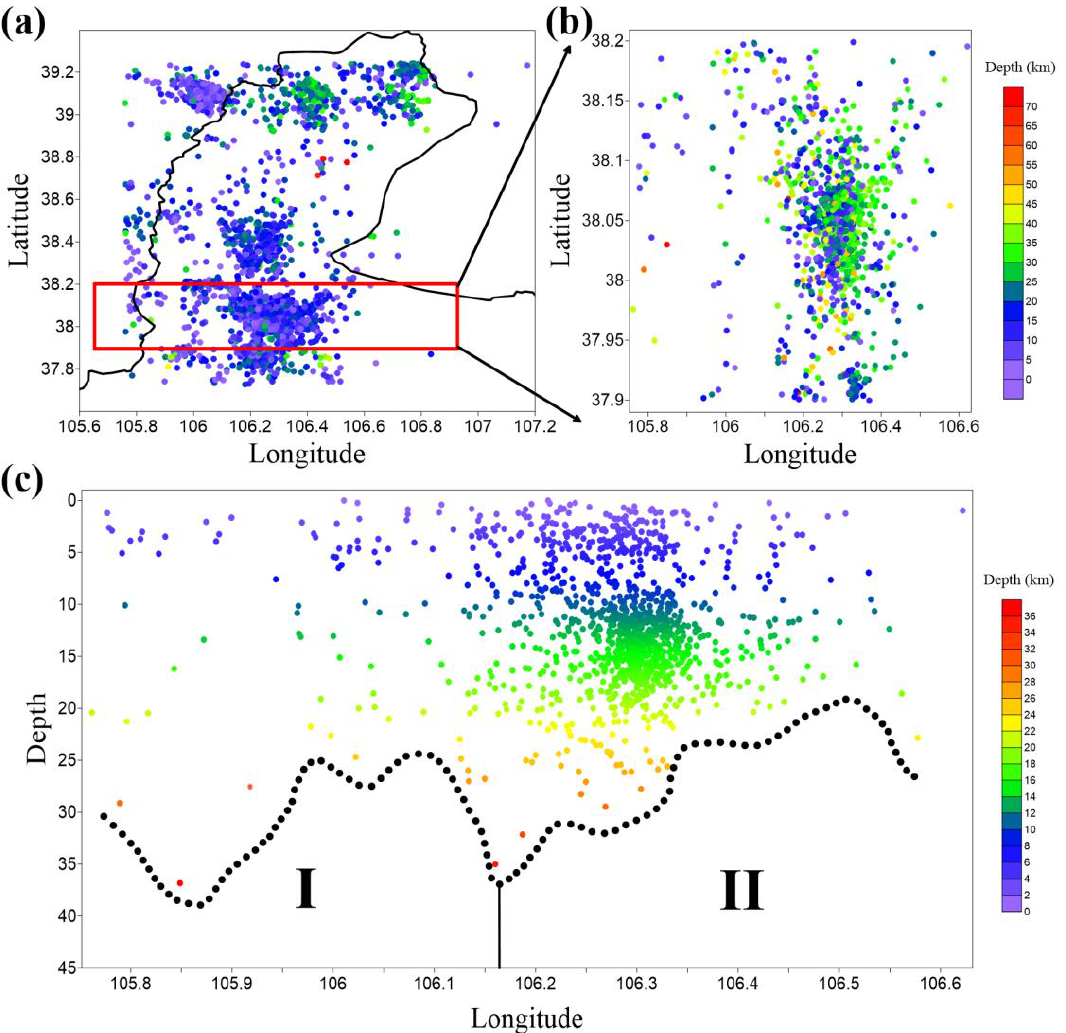
Figure 4. The distribution of earthquake sources from different view. ( a ) Planar perspective profile of earthquake sources; ( b ) Partial planar perspective profile of earthquake sources; ( c ) Vertical perspective profile of earthquake sources. Area I and II are divided by the depth of earthquake source.